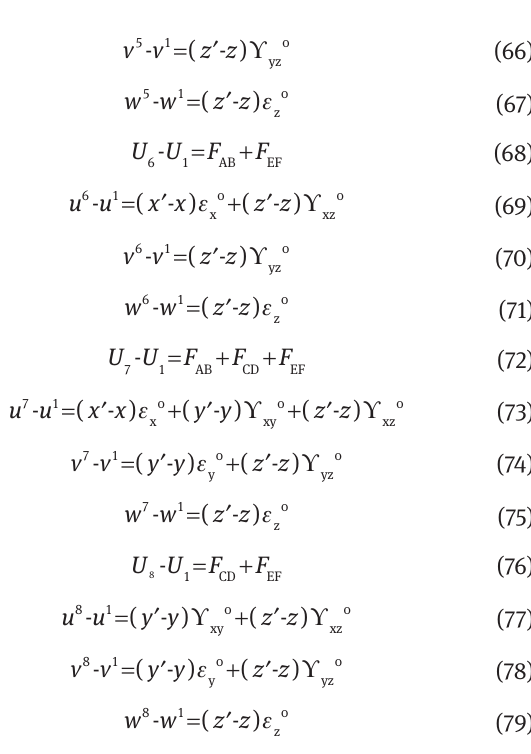
Figure 13: Schematic representations of the vertices